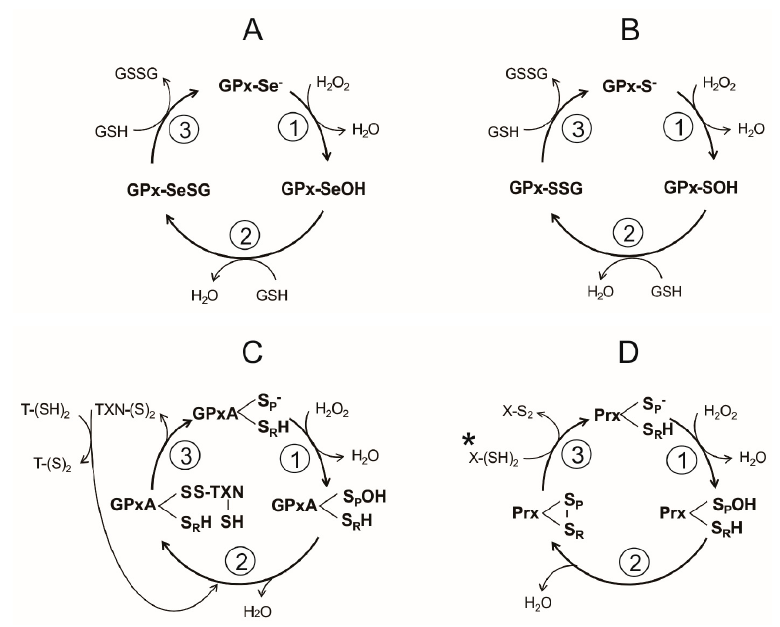
Molecules 2017 , 22 , 259 11 of 35